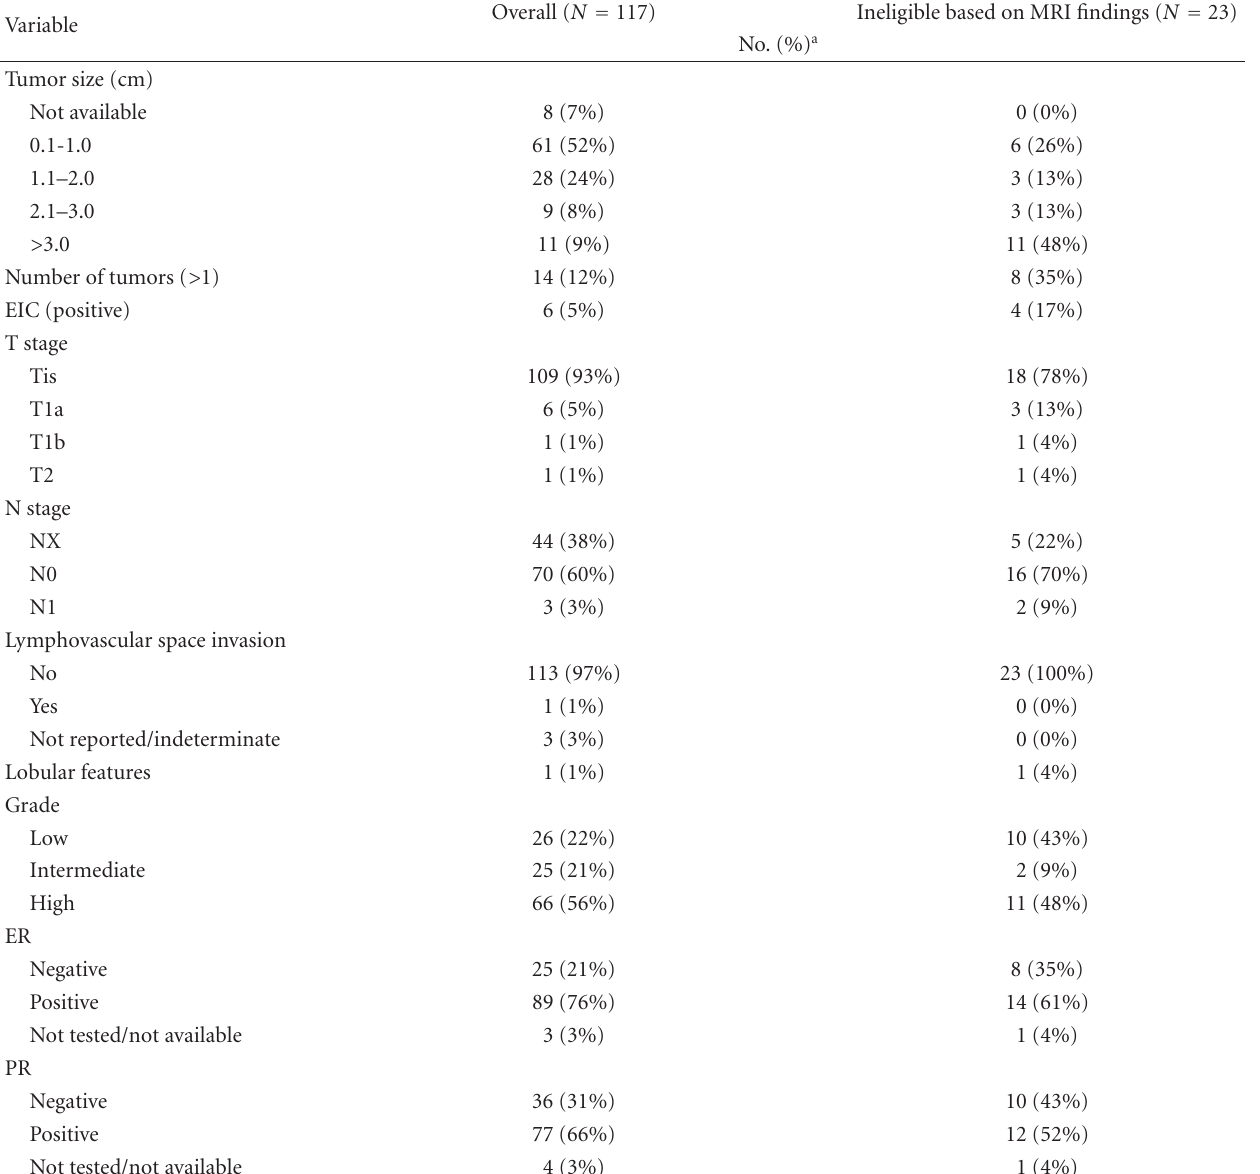
Table 2: Final pathological results for 117 women eligible for partial breast irradiation on the basis of the initial clinical evaluation, and of the 23 women ultimately ineligible by